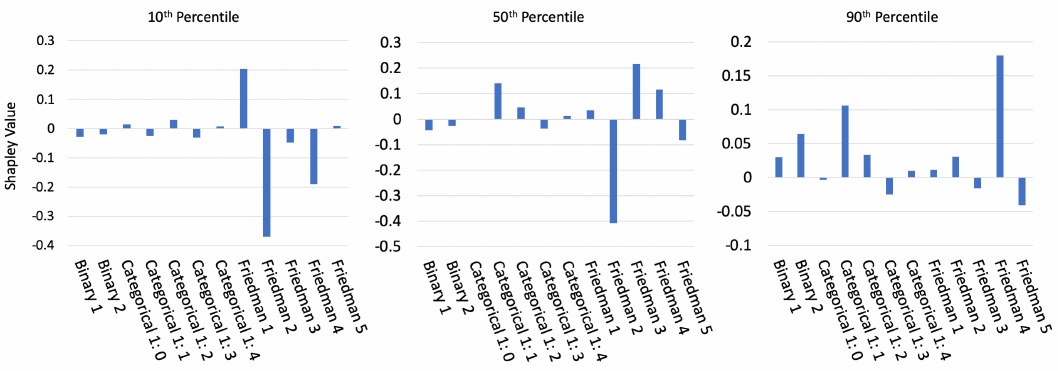
Figure A6. Deep SHAP values for three instances across selected percentiles of g XNN ( X ) on the simulated test